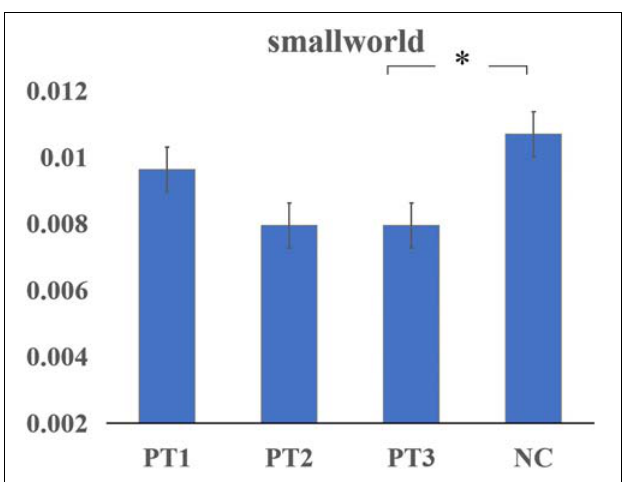
FIGURE 2 | The small-world variance of the dynamic functional network in the PT3 group was significantly smaller than that of the NC group ( P = 0.027). *Means that the difference is statistically significant after multiple